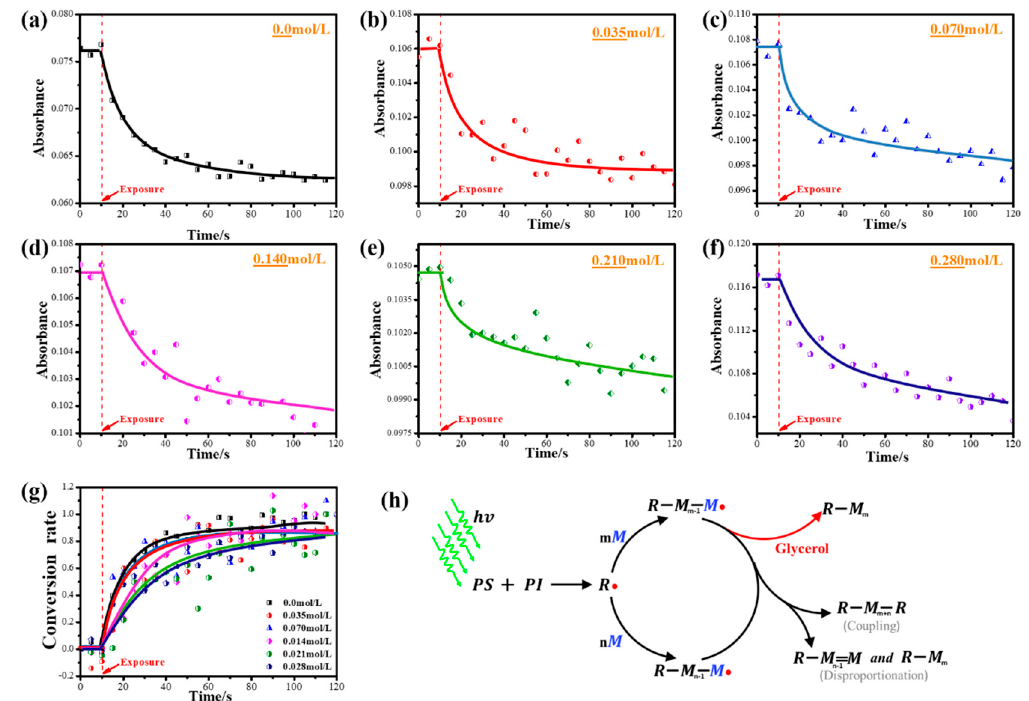
Figure 5. The evolution of the intensity of the δ C − H (986 cm − 1 ) in the photopolymers containing different concentrations of glycerol over time: ( a ) 0.0 mol/L; ( b ) 0.035 mol/L; ( c ) 0.070 mol/L; ( d ) 0.14 mol/L; ( e ) 0.21 mol/L; ( f ) 0.28 mol/L. ( g ) Curve of the conversion rate of NVP in the photopolymers over time. ( h ) Reaction history of the photopolymer. PS and PI are photosensitizer and photoinitiator, respectively; M is monomer; R ∗ is free radical; R − [ M ] 𝑀 ∗ is active polymer m − 1 chain.